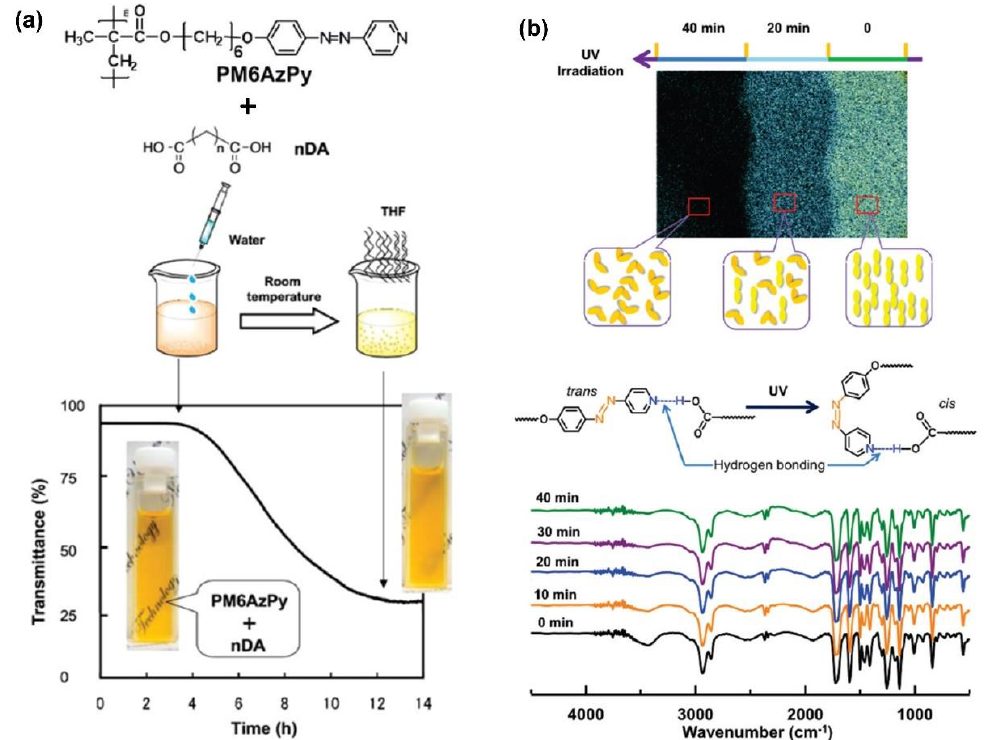
Figure 5. ( a ) Polymer structure and preparation of hydrogen−bonded liquid−crystal materials. ( b ) Photoresponse of the PM6AzPy−10DA film, top: POM image, bottom: FTIR spectra. Adapted with permission from [58]. Copyright 2011, American Chemical Society.